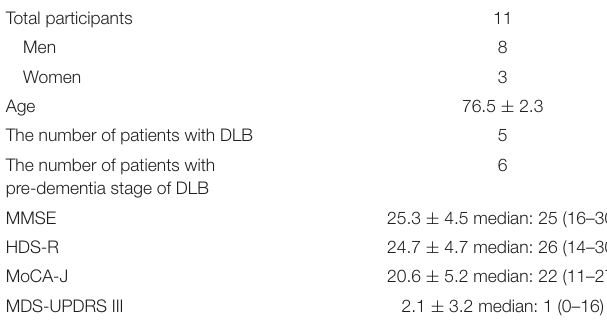
TABLE 3 | The demographic characteristics of